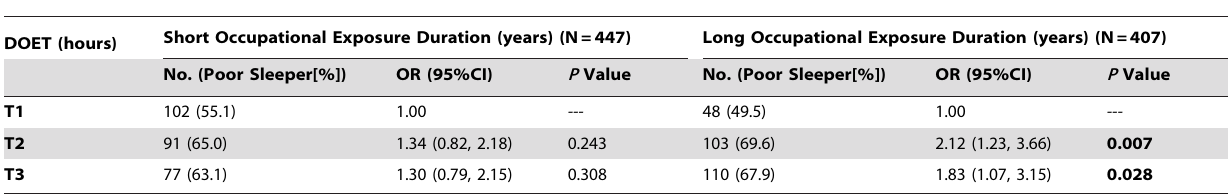
Table 4. The associations a of daily occupational exposure time (DOET) b with sleep quality stratified by occupational exposure duration c .